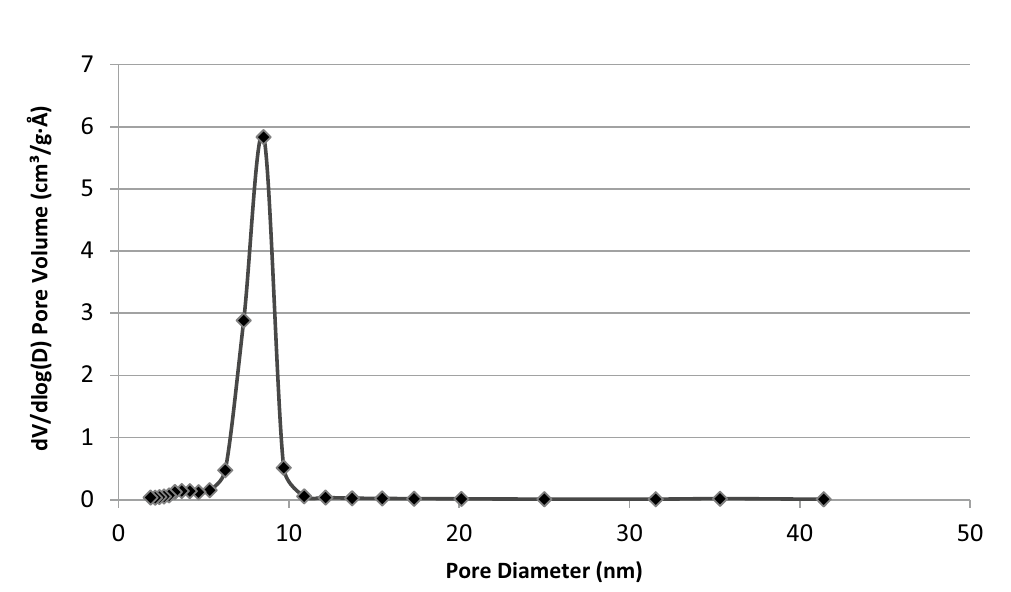
Figure 7. Pore size distribution of silica nanoparticles synthesized from UKMRC-8 rice husk